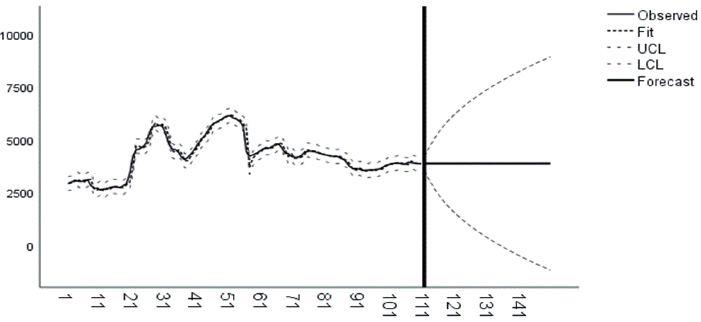
Fig. 5 – Forecasting Wheat food with Damped trend. Source: